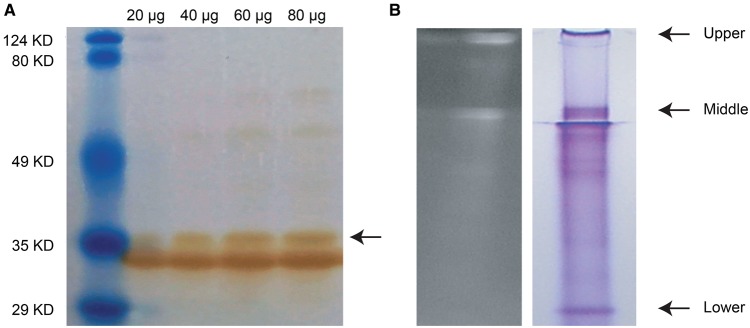

—Hme CTD31 Western Blot. (A) Western blot using head tissue and Hme CTD31 antibody performed by Zyagen (San Diego CA). Arrow indicates expected band. (B) Butterfly head protein run on a native gel shows three bands that fluoresce under UV light. Arrows indicate the location of the upper, middle, and lower bands which were cut out and sequenced using mass spectrometry.